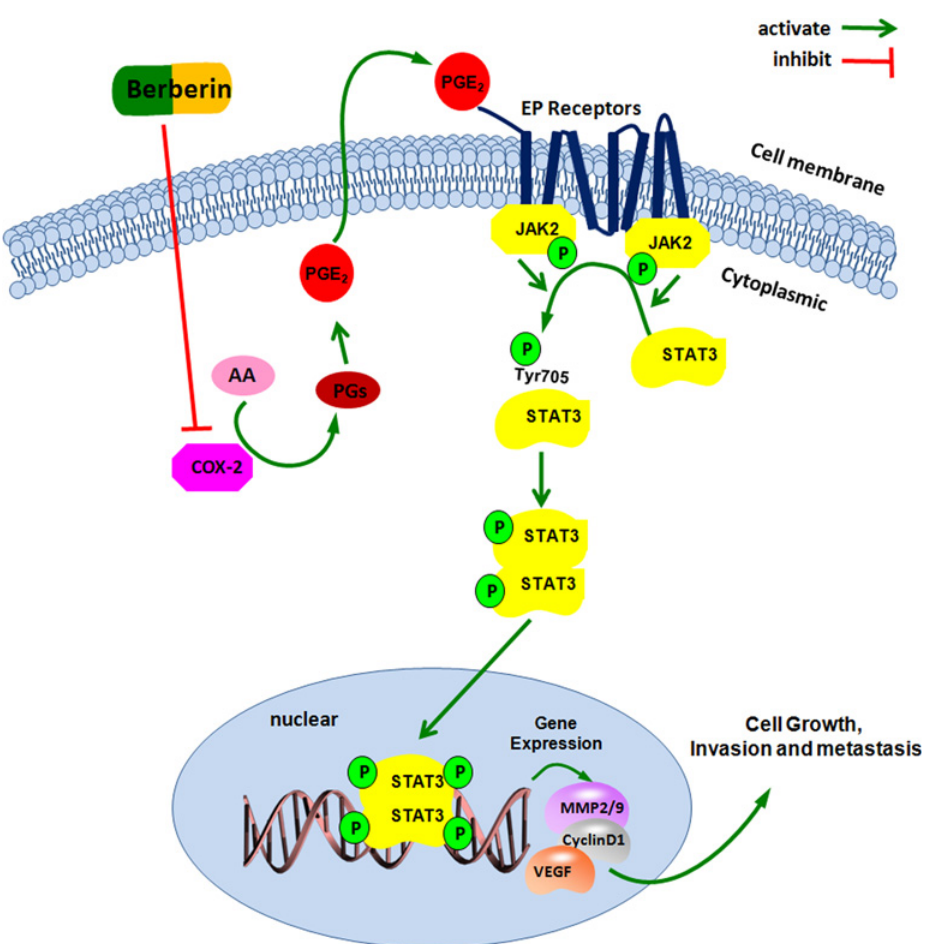
Fig 7. A hypothetical illustration for the role of berberin. PGE2, the main catalyzed product of COX-2 from arachidonic acid, could bind to the EP receptor on the cell membrane, thereby activating the JAK2, followed by the phorphorylating of STAT3 in the Tyr705 site. The activated p-STAT3 forms the homo-or heterodimers, which translocate into the nucleus, bind to the downstream target gene MMP-2, MMP-9, and accelerate the tumor progression. Inhibiting the COX-2/PGE2 mediated JAK2/STAT3 signaling pathway, could be one of the mechanisms of the inhibitory effect of berberin on the invasion and metastasis in colorectal